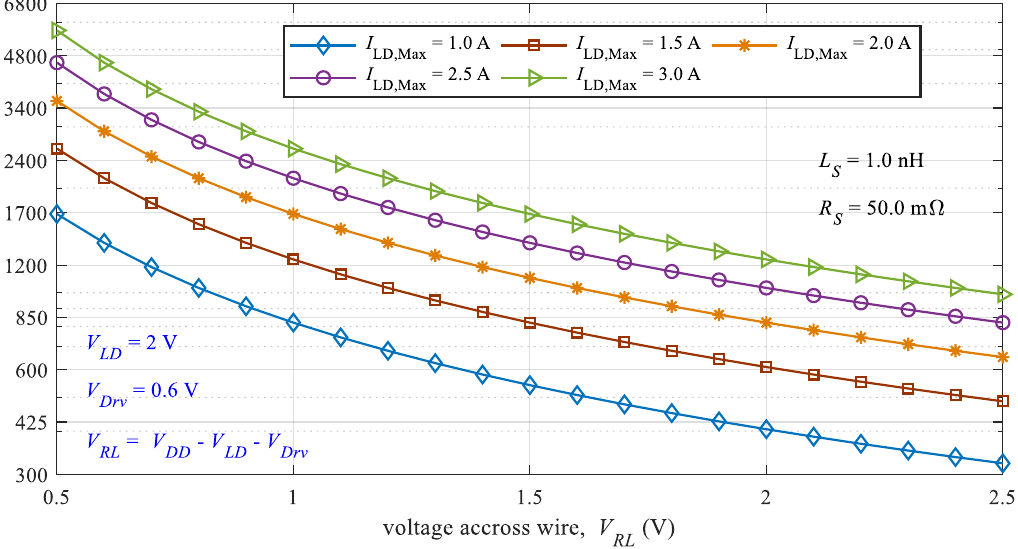
Figure 2. Rise time reduction by increasing voltage across wire.